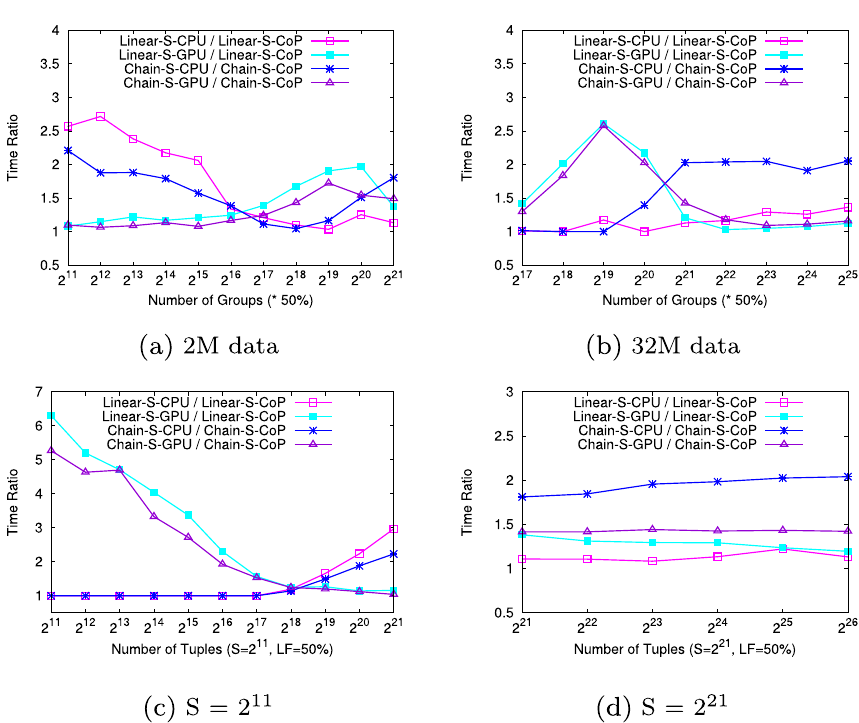
Fig. 16 Performance of the intra-operator co-processing strategy on the uniform data